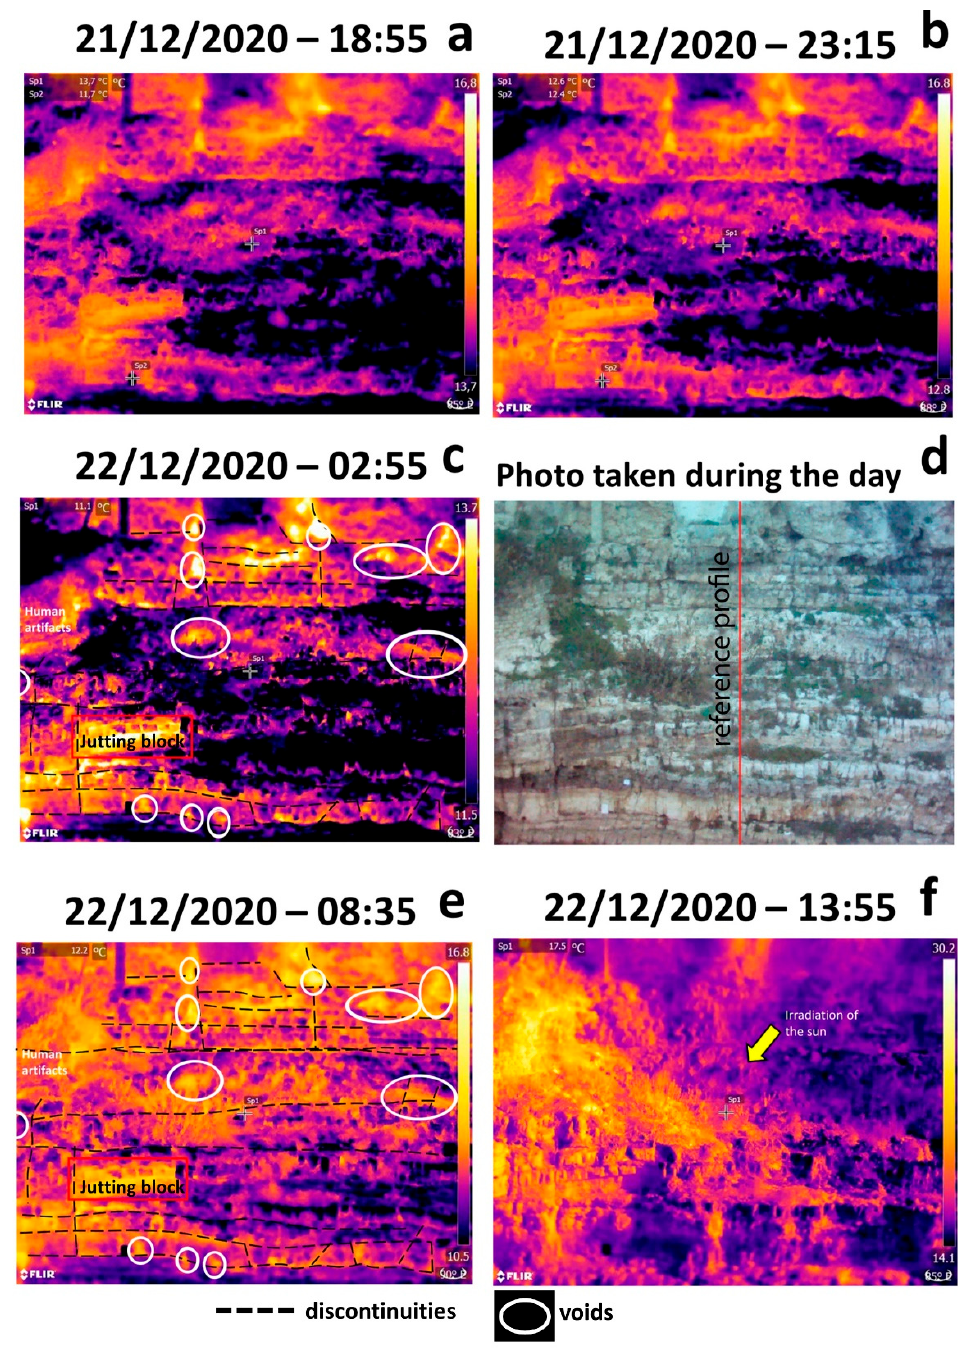
Figure 9. Detection of discontinuities and voids in the thermal images acquired during the 24-h monitoring. ( a – c ) Cooling phase: the discontinuities and voids were identified as warmer anomalies, in contrast with the intact rock which was colder; ( d ) RGB photo acquired by the thermal imager during the day; ( e , f ) heating phase: the discontinuities and voids gain more heat than the intact rock (low thermal diffusivity), but their contours are less defined. ( e ) The more porous calcarenite facies is identified in the form of warm thermal anomaly; ( f ) the discontinuities and voids cannot be detected because of the effects of direct solar radiation on the rock mass.